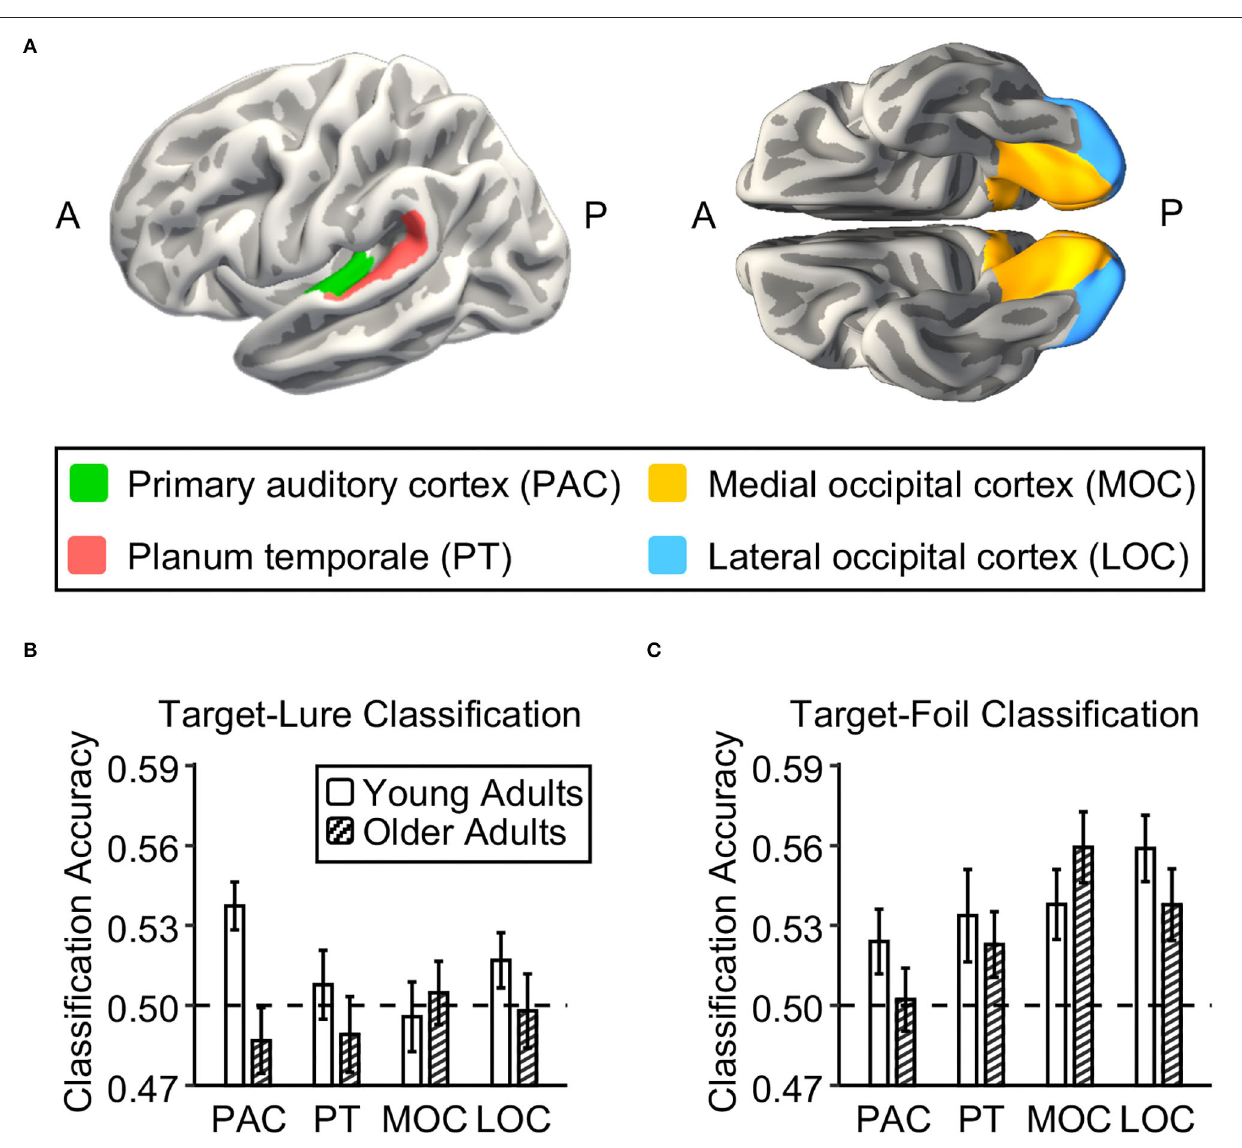
FIGURE 2 | Neural discriminability in auditory and visual cortex in young and older adults. (A) Four brain regions of interest (ROIs) in the auditory and visual cortex were defined using Freesurfer segmentation. Two auditory ROIs were the primary auditory cortex (PAC; green) and planum temporale (PT; red). Two visual ROIs were the medial occipital cortex (MOC; yellow) and the lateral occipital cortex (LOC; blue). (B,C) Bar graphs show the mean accuracy for the classifier trained to distinguish between targets and lures and to distinguish between targets and foils in each ROI in young adults and in older adults, respectively. The dashed lines indicate the theoretical chance level. The error bars indicate the standard errors of the